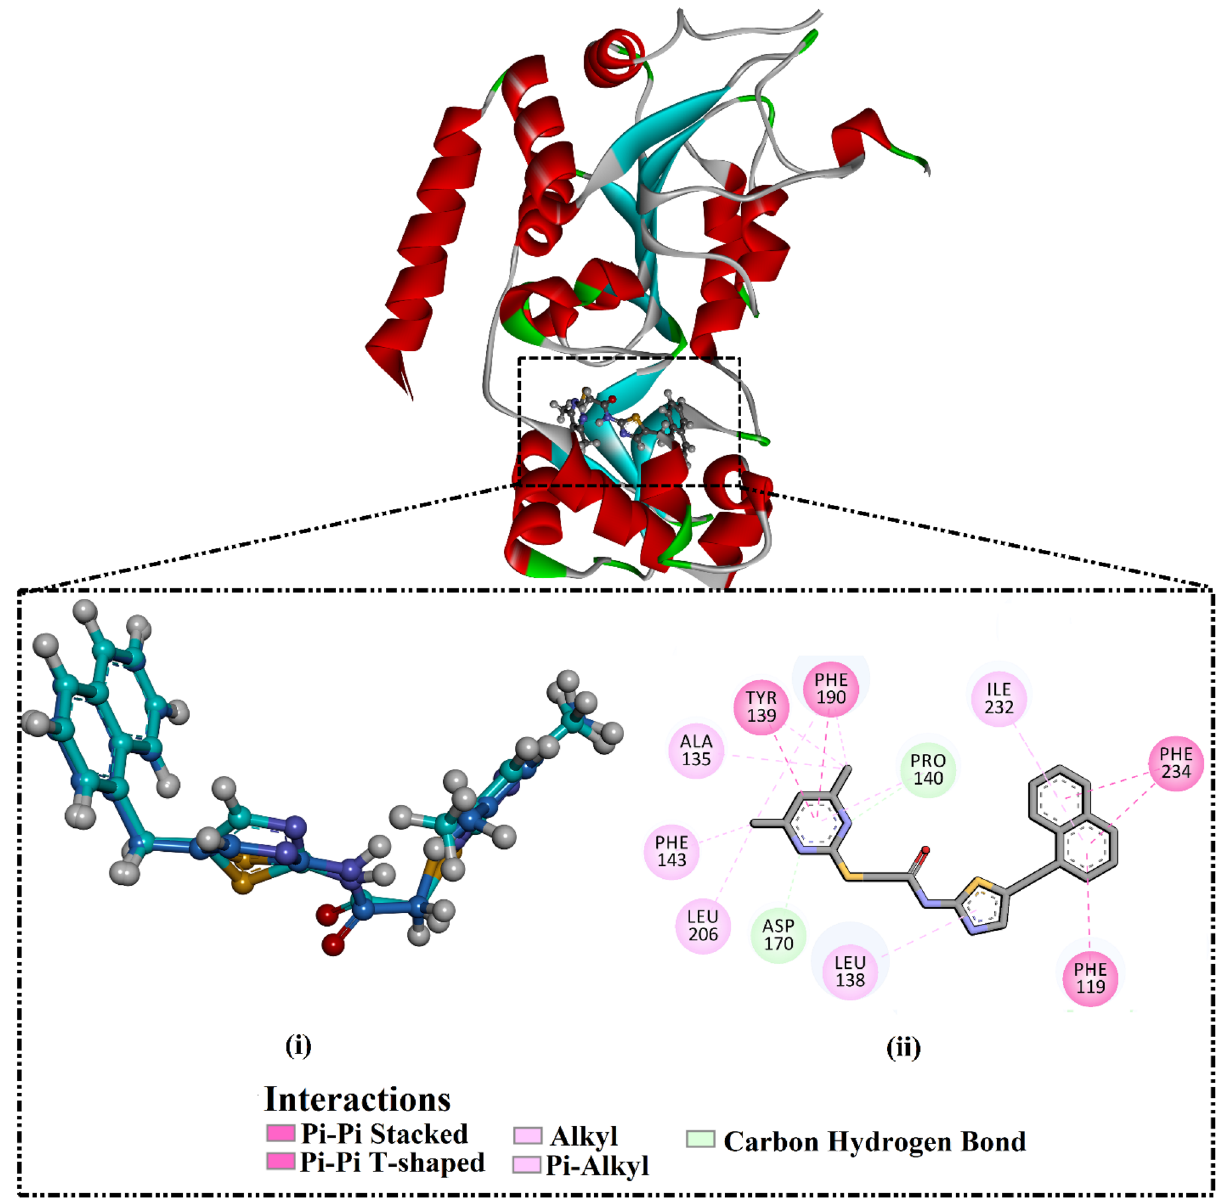
Figure 3. (i) 3D representation of the native structure (in blue) and the anticipated binding mode (in cyan) of SirReal2 and (ii) 2D molecular interaction of the predicted docking pose of SirReal2 inhibitor with SIRT2